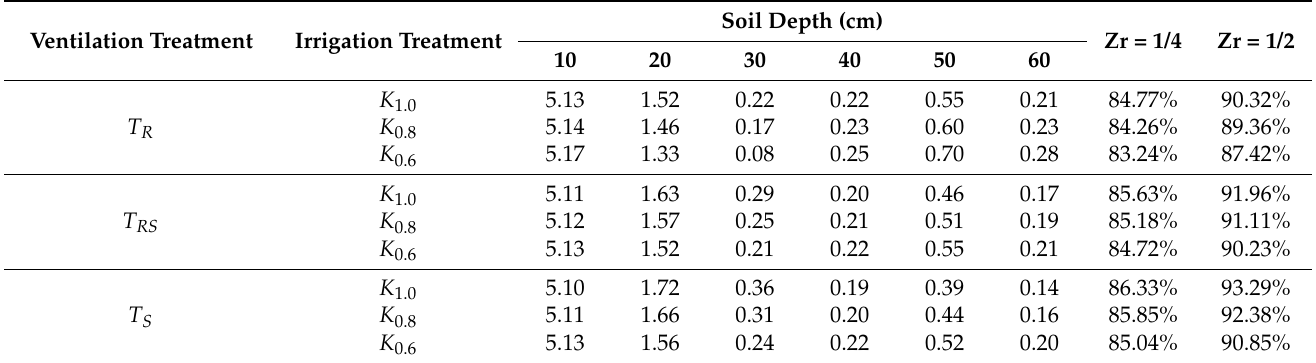
Table 5. Predicted root distribution in 2020 by setting different evaporation coefficient (1.0, 0.8 and 0.6).